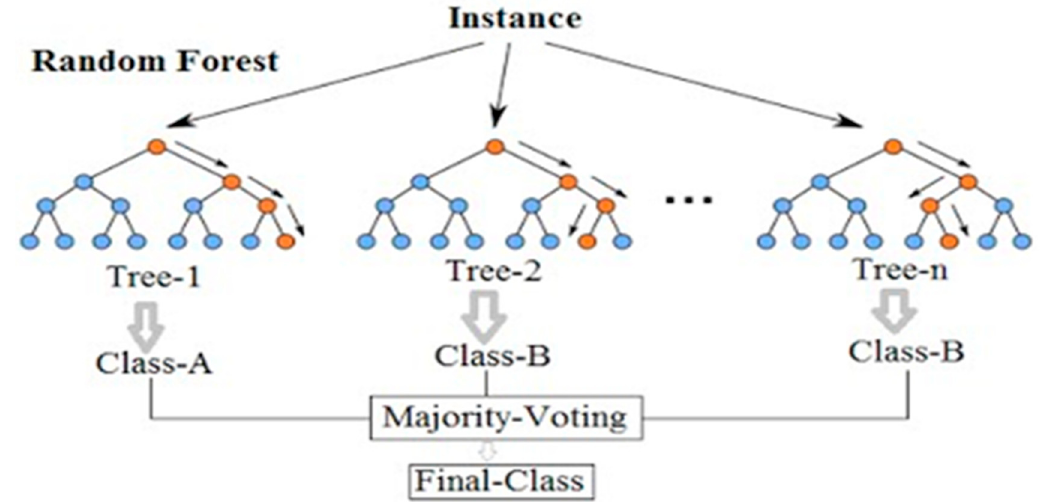
Figure 9. Flow chart of support vector machine .